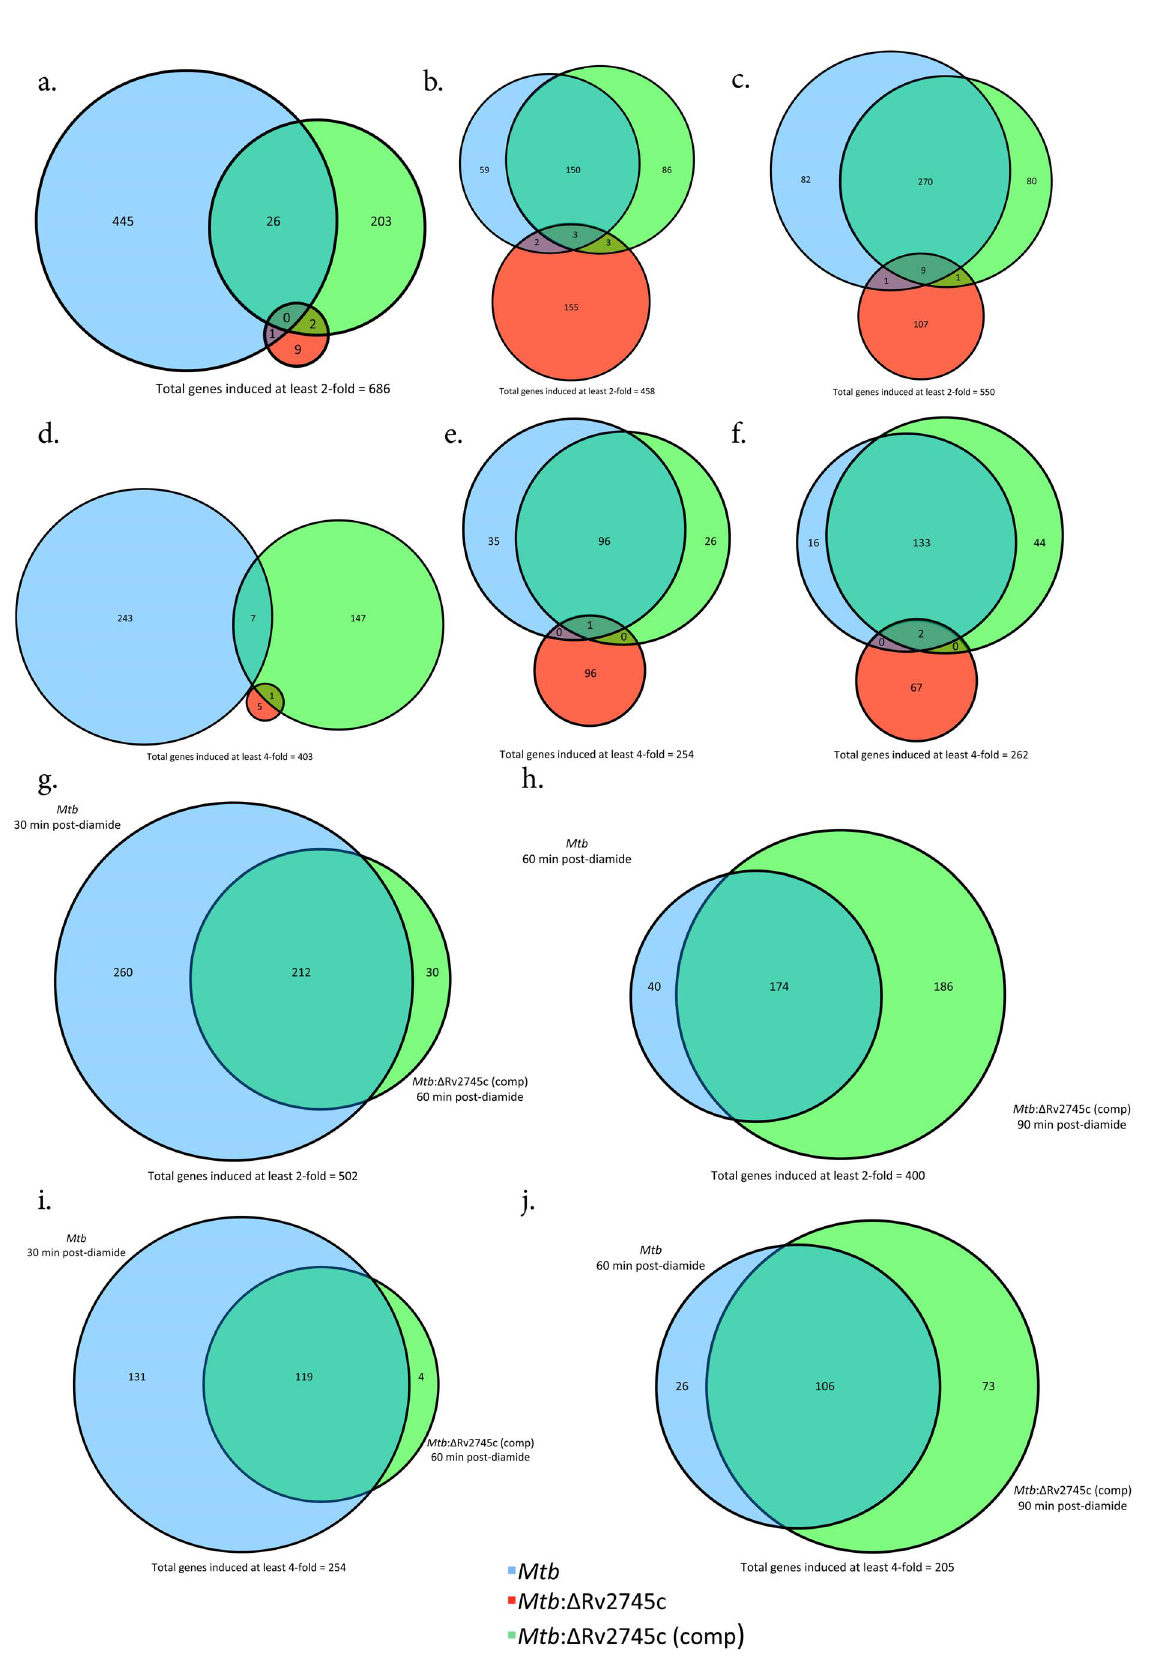
Figure 2. Venn Diagrams of Diamide Induced Genes. Venn diagrams describe the extent of overlap between gene-expression upon diamide treatment in Mtb (blue circles), Mtb : D Rv2745c (red circles) and Mtb : D Rv2745c (comp) (green circles). Genes induced at least two-fold at: a.) 30, b.) 60,